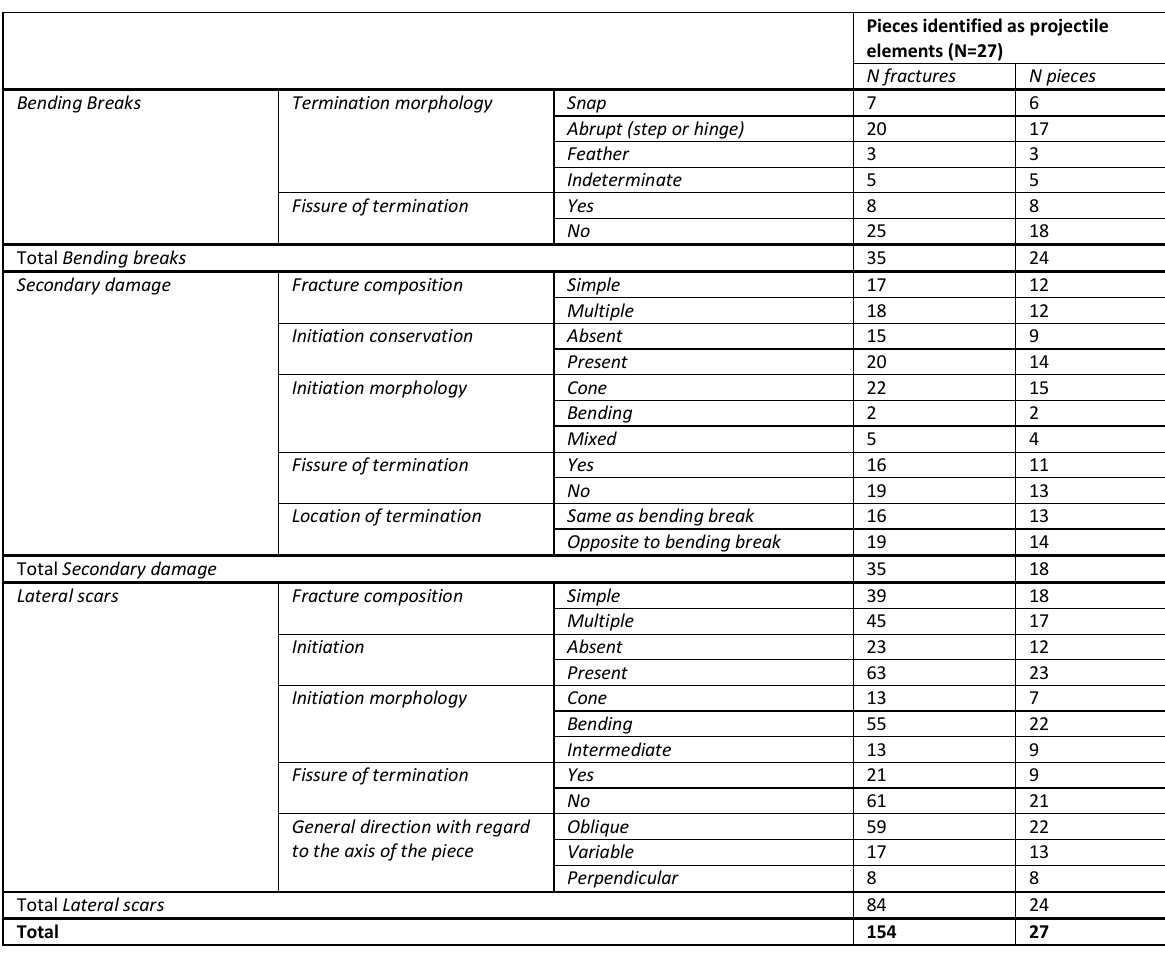
Table 9. Details of the representation of the different fractures attributes inside the sample of identified projectile from LB25